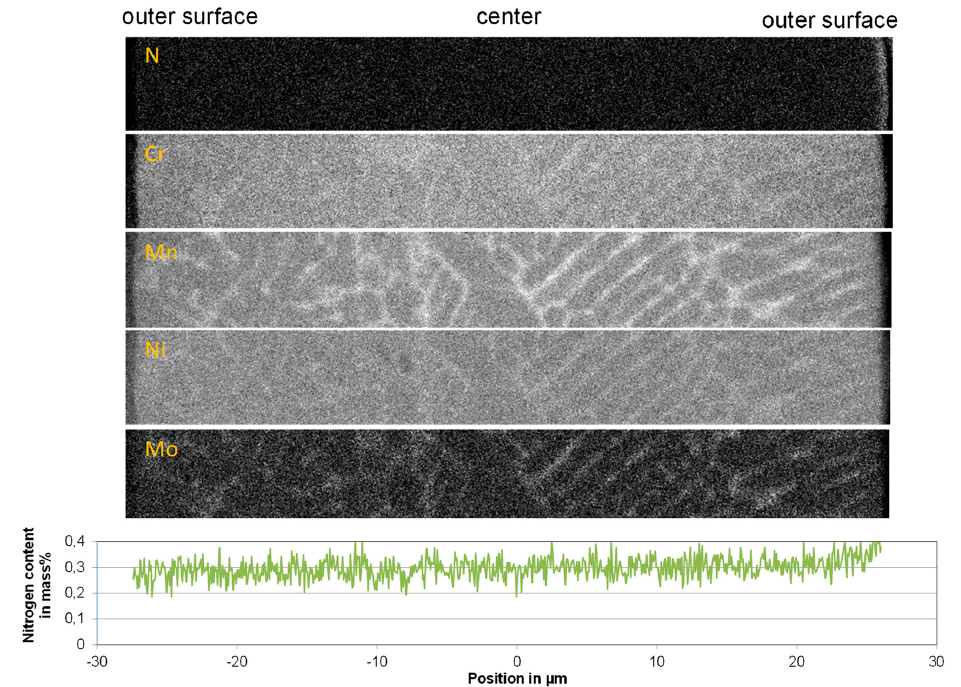
Figure 9. Element mapping (EPMA) on the cross section of a 316L-Low Ni-2 N 2 / N 2 (Run 6) particle from the powder faction of 20–63 µ m and the nitrogen concentration line scan on the cross section of the particle. In total, 100 lines scans were conducted on the particle at a distance of 0.0698 µ m; the mean values are plotted in the diagram.